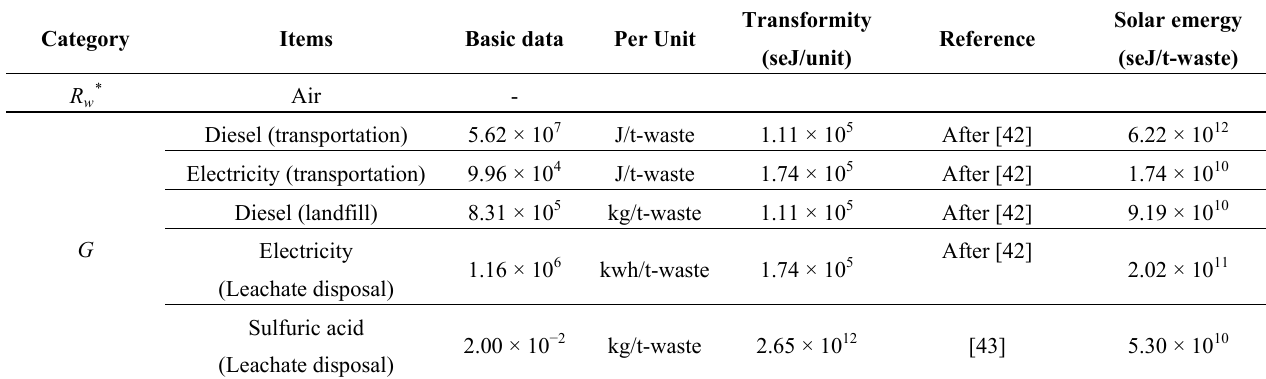
Table 5. The emergy analysis table of current